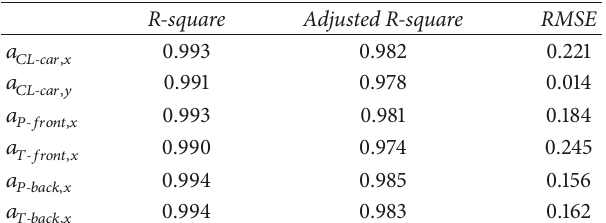
Figure 17: Acceleration curve of T-front in the positive direction of X-axis with time. Table 5: Fitting effect indicators.